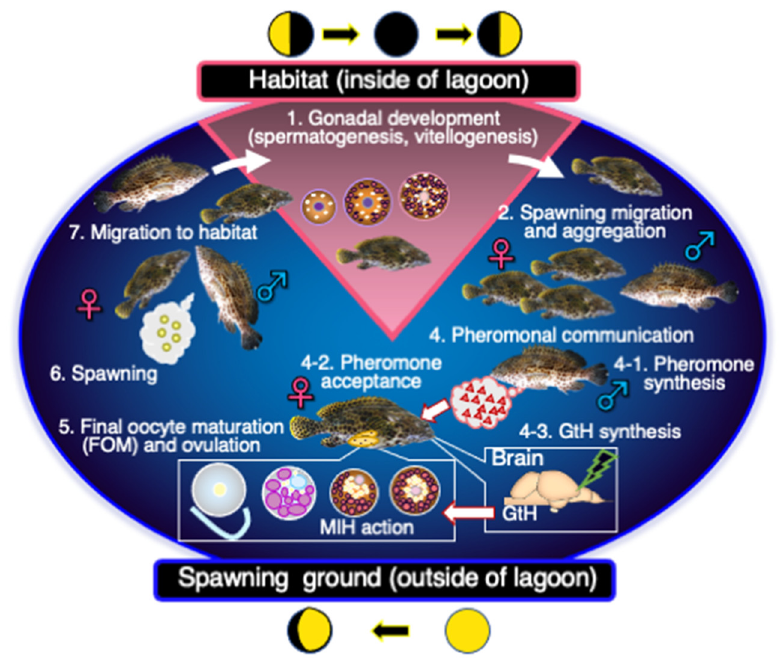
Figure 4. Maturation mechanisms of the honeycomb groupers in Okinawa, Japan. Relationships among the migration from habitat to spawning grounds, maturation, physiological changes, and endocrine changes in the grouper. The southern type groupers, including the honeycomb grouper, are lunar-related spawners. They migrate to suitable spawning grounds just after the full moon for final oocyte maturation and spawning.